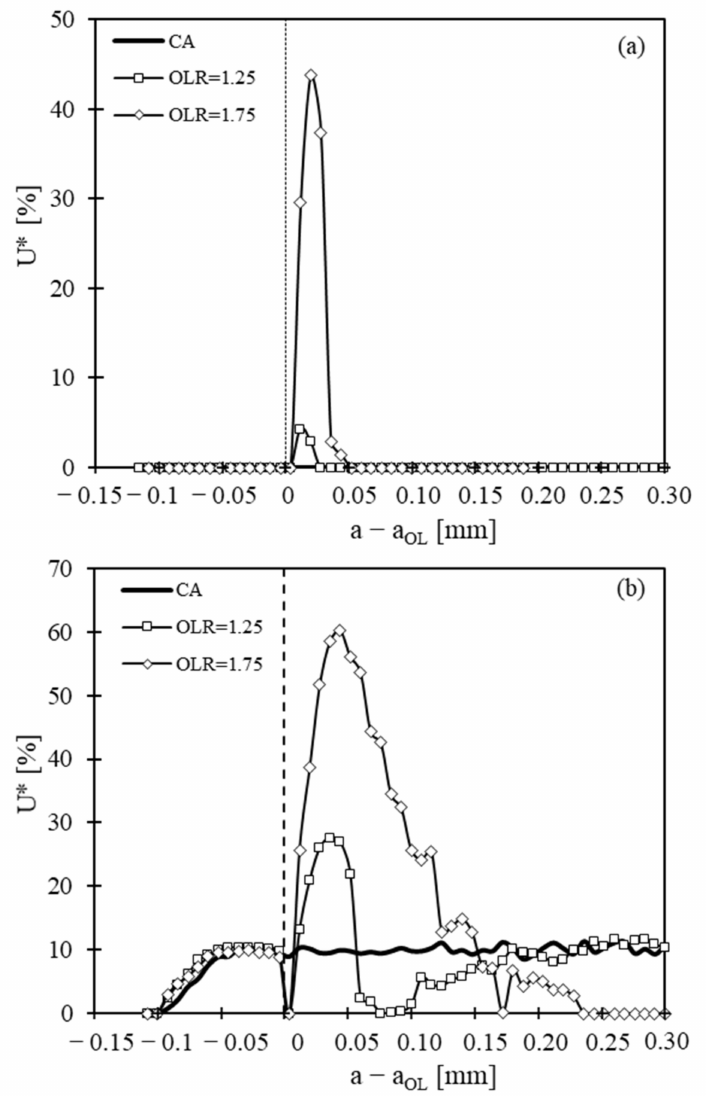
Figure 10. Numerical prediction of crack closure level with the application of a single tensile overload √ (a OL = 16.12 mm; ∆ K BL = 18.3 MPa m), applying boundary conditions for: ( a ) Plane strain state; ( b ) Plane stress